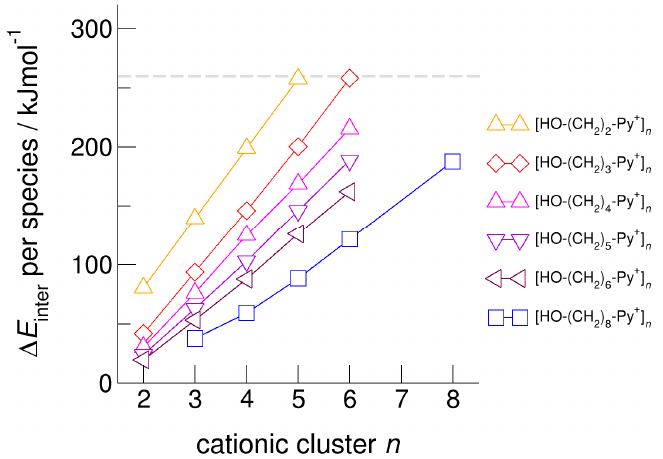
Figure 6. Intermolecular energies per species in the cationic clusters [HO-(CH 2 ) x -Py + ] n with x = 2–6 calculated at the B3LYP-D3 / 6–31 + G* level of theory. The dashed grey line indicates meta-stability of the cationic clusters with energies below 260 kJ mol − 1 per cation. Beyond this energy, the cationic clusters undergo “Coulomb explosion” and dissociate [53]. We also added recently calculated energies for cationic clusters [HO-(CH 2 ) 8 -Py + ] n [59]. The hydroxyl alkyl chain length dependence of [HO-(CH 2 ) x Py + ] n clusters is nicely reflected in the H-bond geometries and spectroscopic properties such as NMR 1 H proton chemical shifts, δ 1 H, and deuteron quadrupole coupling constants, χ D . Despite strong electrostatic opposition, the cationic clusters show typical H-bond distances and spectroscopic signatures as known for molecular liquids. The intramolecular bond lengths, r (OH) , and the intermolecular bond distances, r (O…O) of the cationic clusters [HO-(CH 2 ) x -Py + ] n are shown in Figures 7 and 8. Stronger hydrogen bonds are reflected in